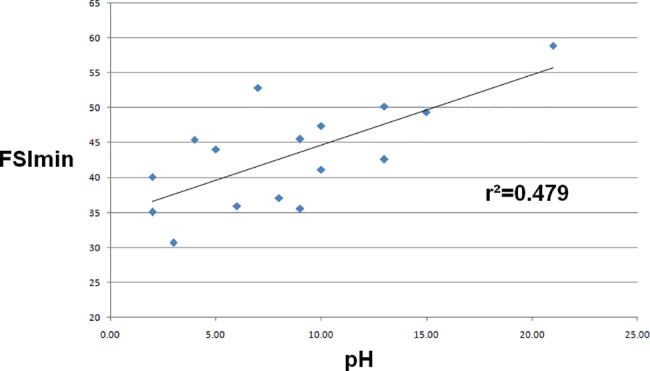
Correlation curve between FSImin and base deficit.